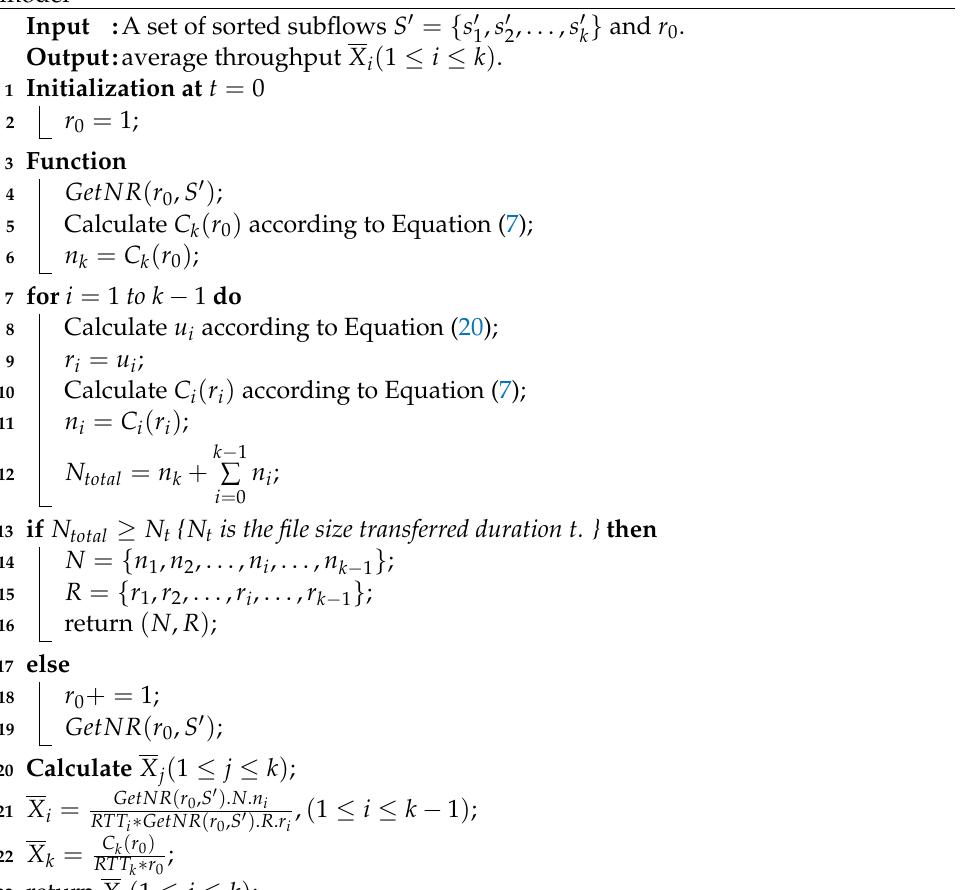
Algorithm 1: Estimate the average throughput based upon loss-throughput model